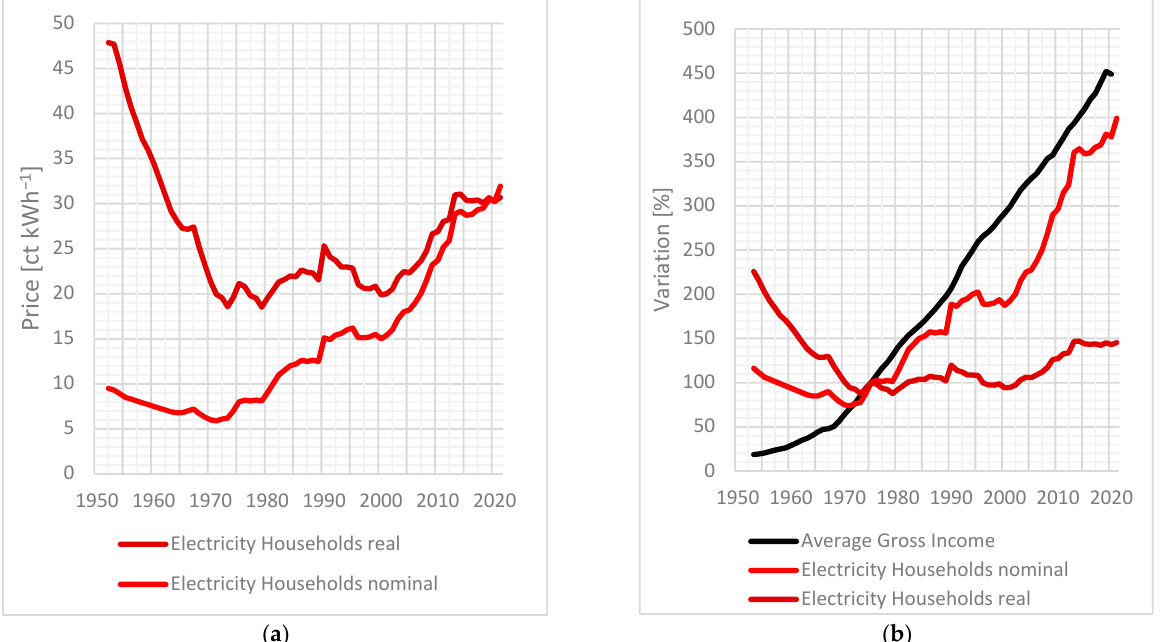
Figure 4. Nominal and real electricity prices for private end consumers and development of average gross incomes: ( a ) Development of nominal and real German end consumer electricity prices until the end of the second quarter 2021. Calculation of real prices in Euro 2020 according to the consumer price index [47,49,50]. ( b ) Comparison of the average gross income to nominal and real (Euro 2020 ) electricity prices in percent and normalized to 1975 = 100% [51].